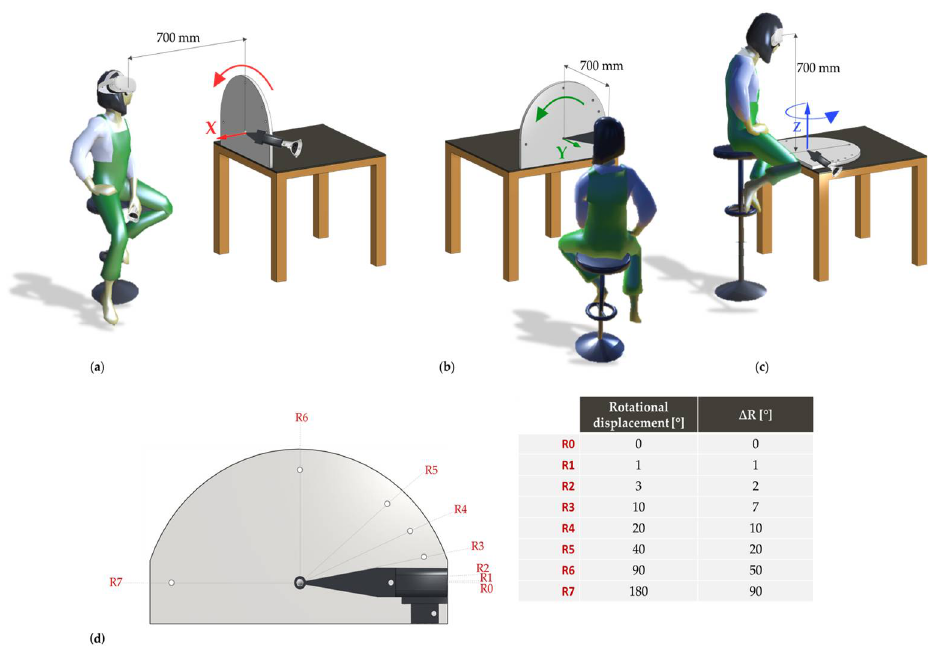
Figure 4. Acquisition configuration of rotational displacements around the ( a ) x-axis, ( b ) y-axis, and ( c ) z-axis, starting at a distance of about 700 mm from the reference position R0; ( d ) representation of rotational displacements R i (i = 1, . . . ,11) and variations ( ∆ R , i.e., differences between rotational displacements i th and i th − 1